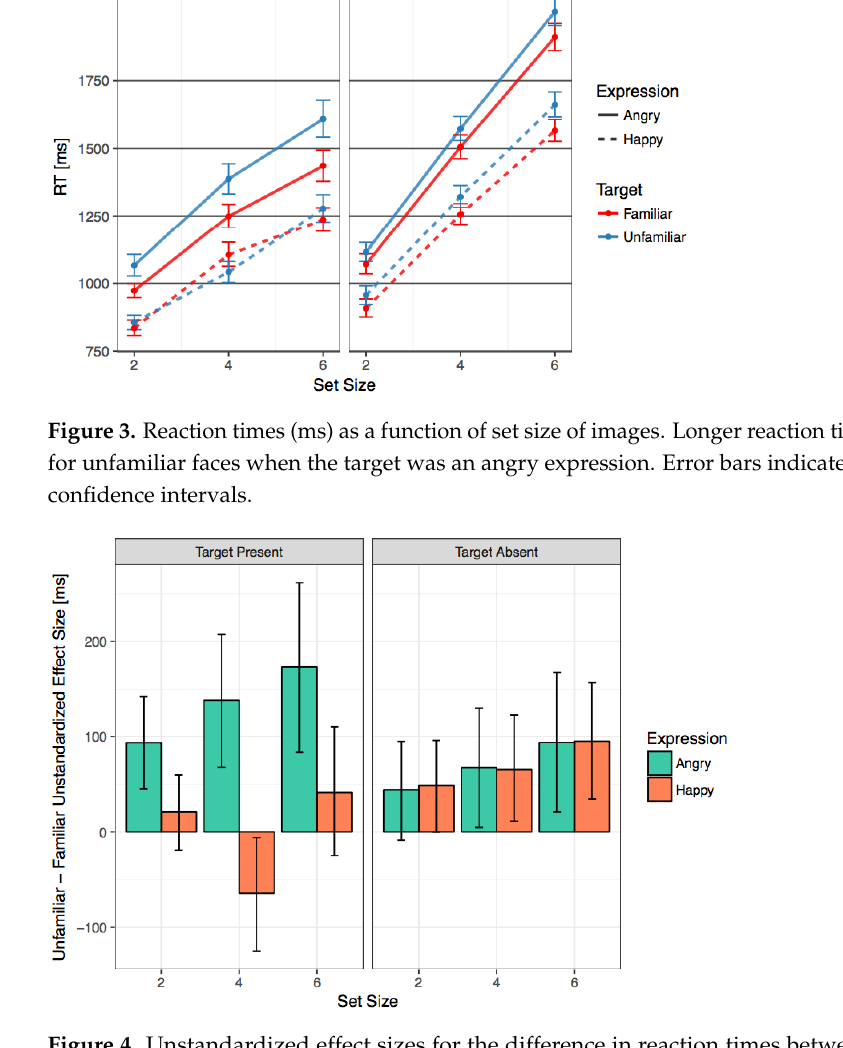
Figure 4. Unstandardized effect sizes for the difference in reaction times between unfamiliar and familiar faces as a function of set size. Error bars indicate 95% bootstrapped confidence